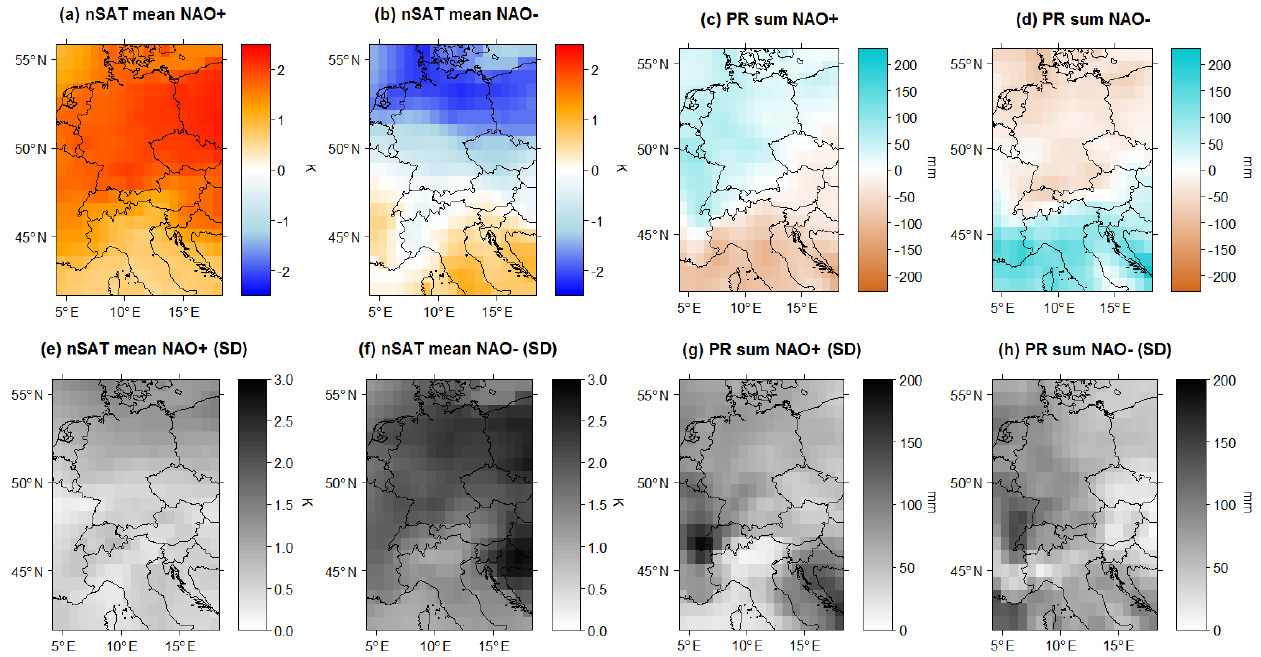
Figure A4. ERA-I anomalies from the long-term mean of nSAT mean in K and PR sum in mm in NAO positive (1989, 1990, 1994, 1995) and negative (1996, 2001, 2010) winters. Mean index value for positive (negative) NAO phases is + 1 . 498 ( − 2 .